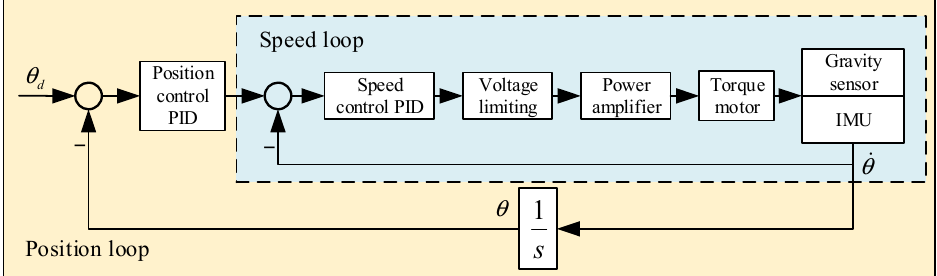
Figure 3. Stabilized platform system composition and the principle block diagram.